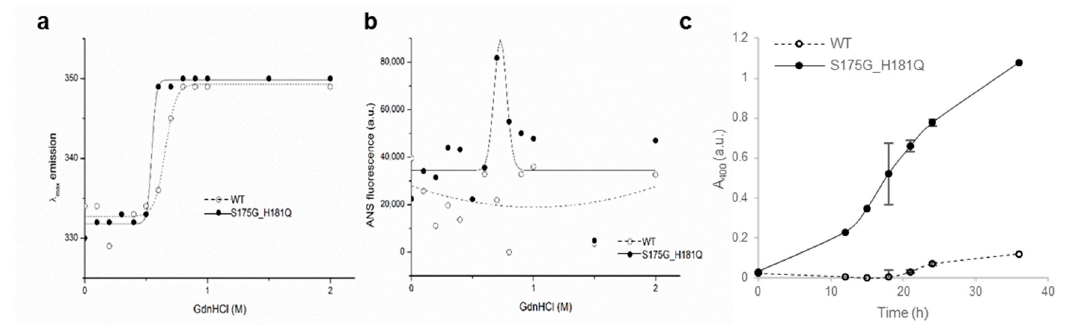
Figure 2. Denaturation of β B2-crystallin protein with various concentrations of GdnHCl. ( a ) Transition curves of protein equilibrium unfolding monitored by Emax of Trp intrinsic fluorescence (Ex: 280 nm). Data for each protein samples were fitted with a Boltzmann curve using Origin 8.5 (OriginLab Corporation, Northampton, MA, USA). The Emax did not change at GdnHCl concentrations above 1 M. ( b ) Hydrophobic exposure during GdnHCl-induced unfolding was monitored by ANS fluoresescence intensity at 470 nm. Data for each proteins were fitted with a GaussAmp curve using Origin 8.5. ( c ) Long-term stability revealed by incubating 5.0 mg/mL proteins at 37 °C continuously, and turbidity changes at 400 nm were measured.